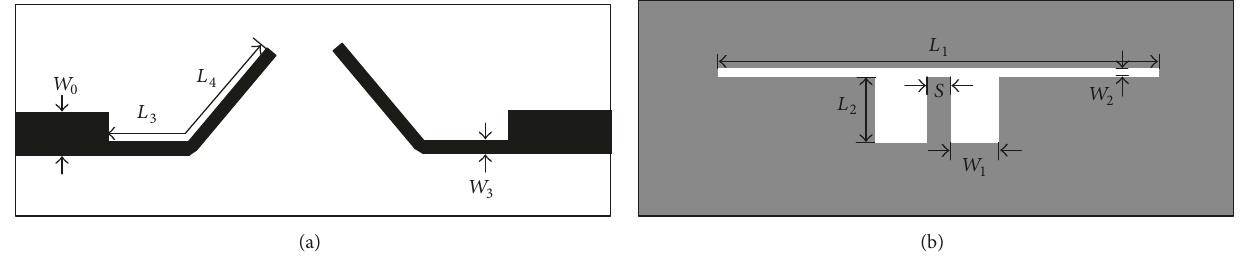
Figure 3: Schematic of the UWB filter. (a) Top layer and (b) bottom